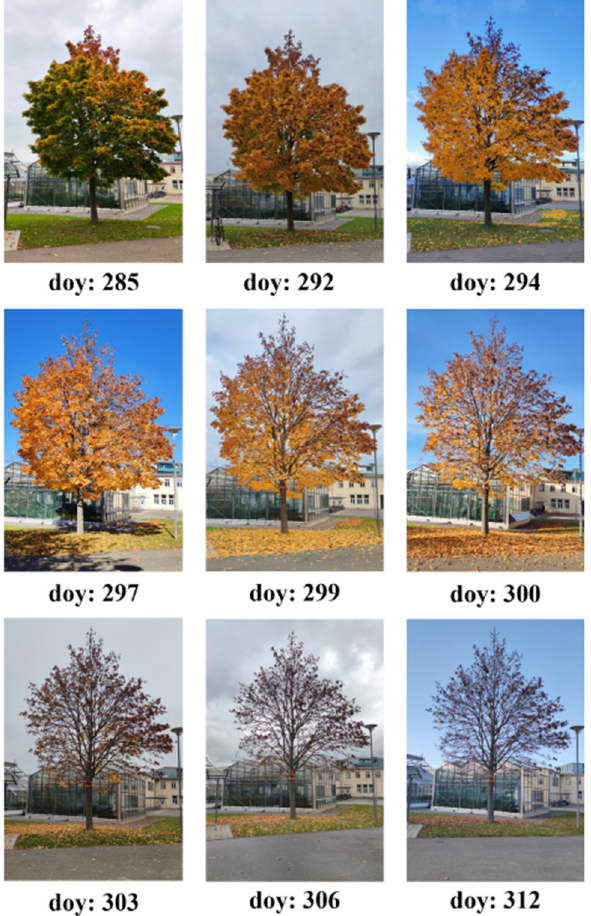
Figure 13. Photo series of the considered tree that were taken during the